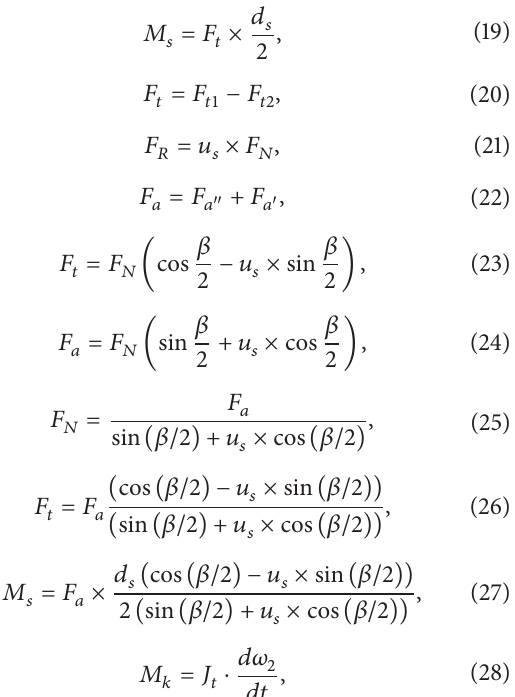
stages 1 and 3 are different, they have the same force situation. teeth at the contact